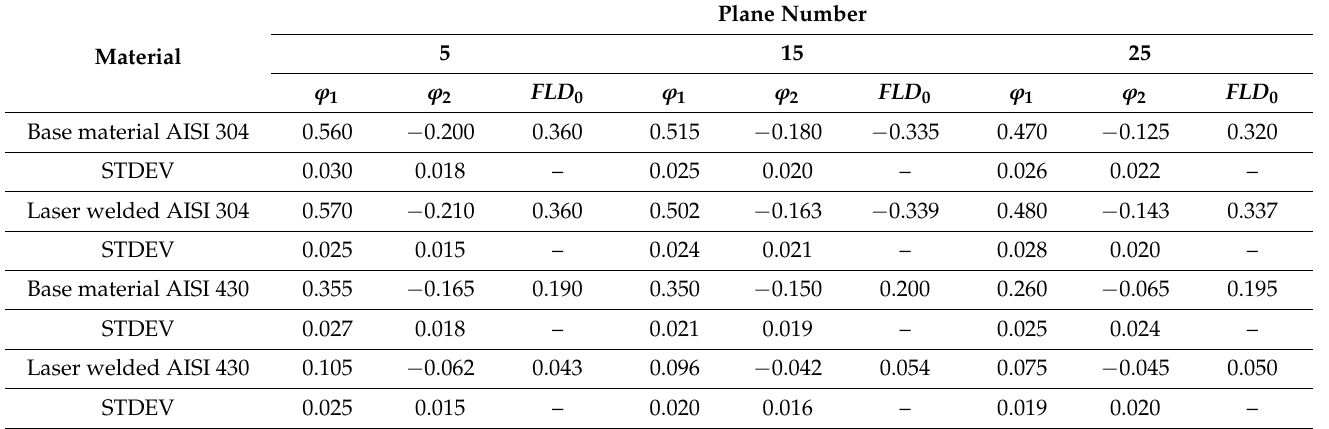
Table 5. Minimum strain values measured at the onset of fracture formation and at the onset of necking in the base material and the laser-welded